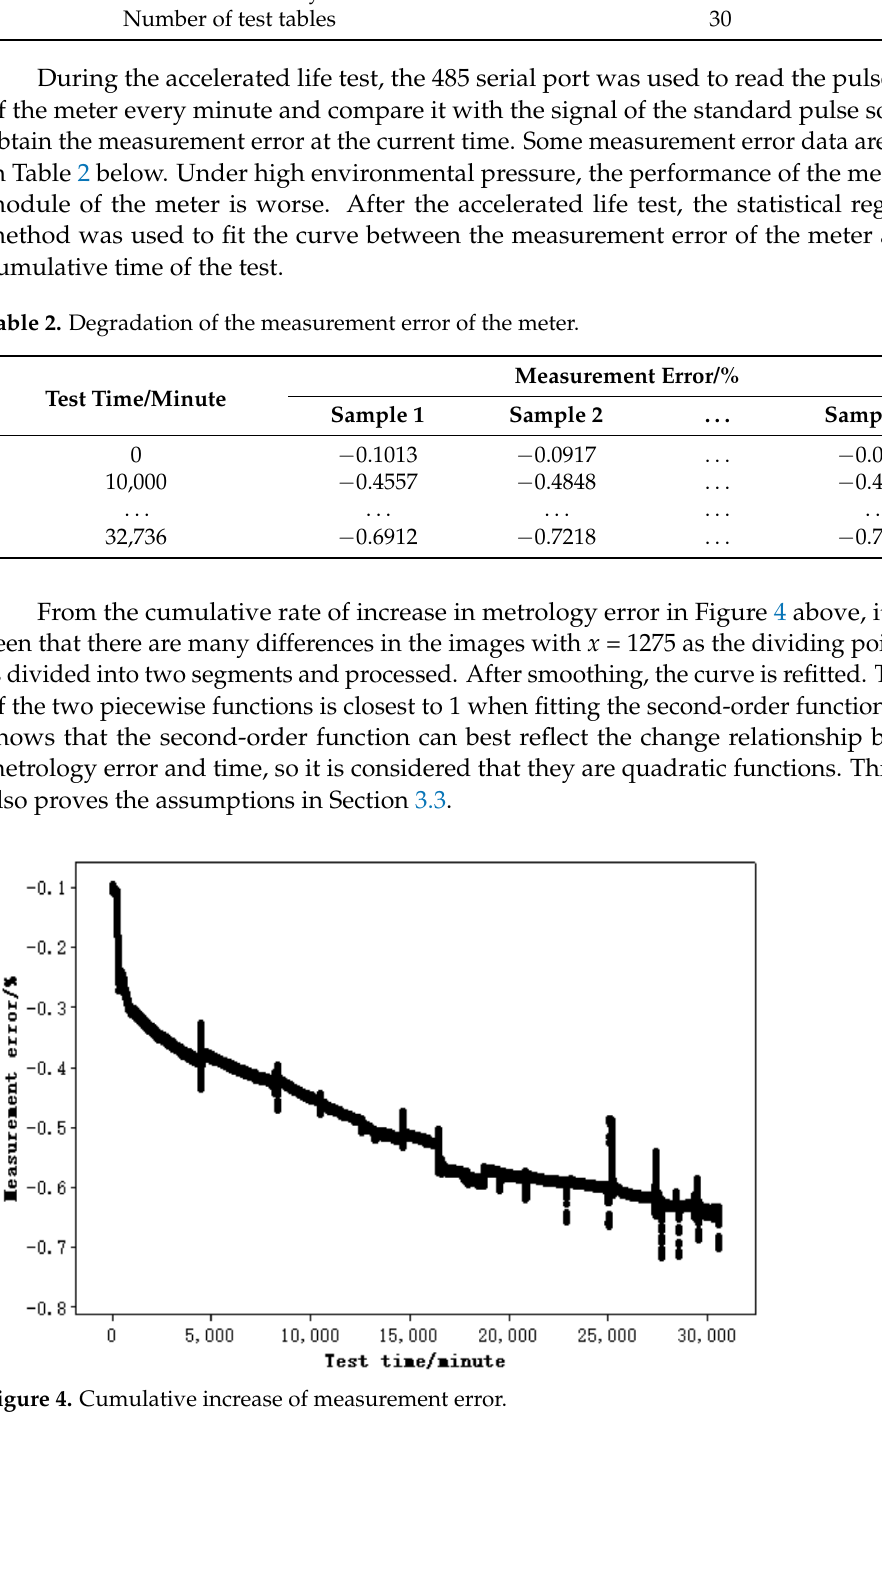
Table 1. Electrical life test parameters.